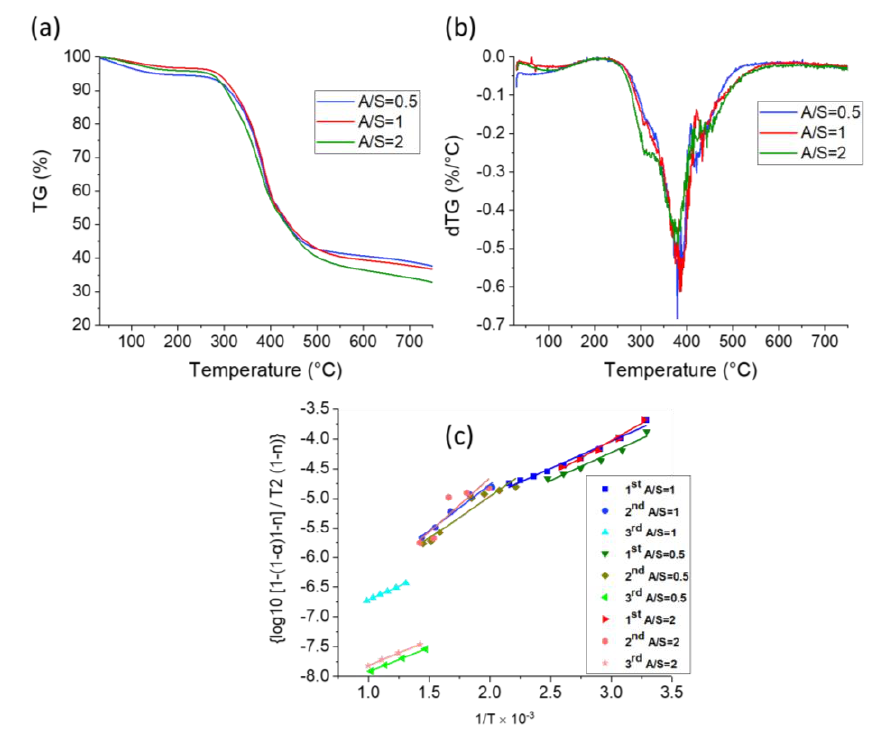
Figure 3. ( a ) TGA and ( b ) DTG of A/S = 1, A/S = 0.5, and A/S = 2; ( c ) their thermal kinetics. Table 2. TGA results and thermodynamic and kinetic parameters of the hydrogels’ degradation in N 2 .